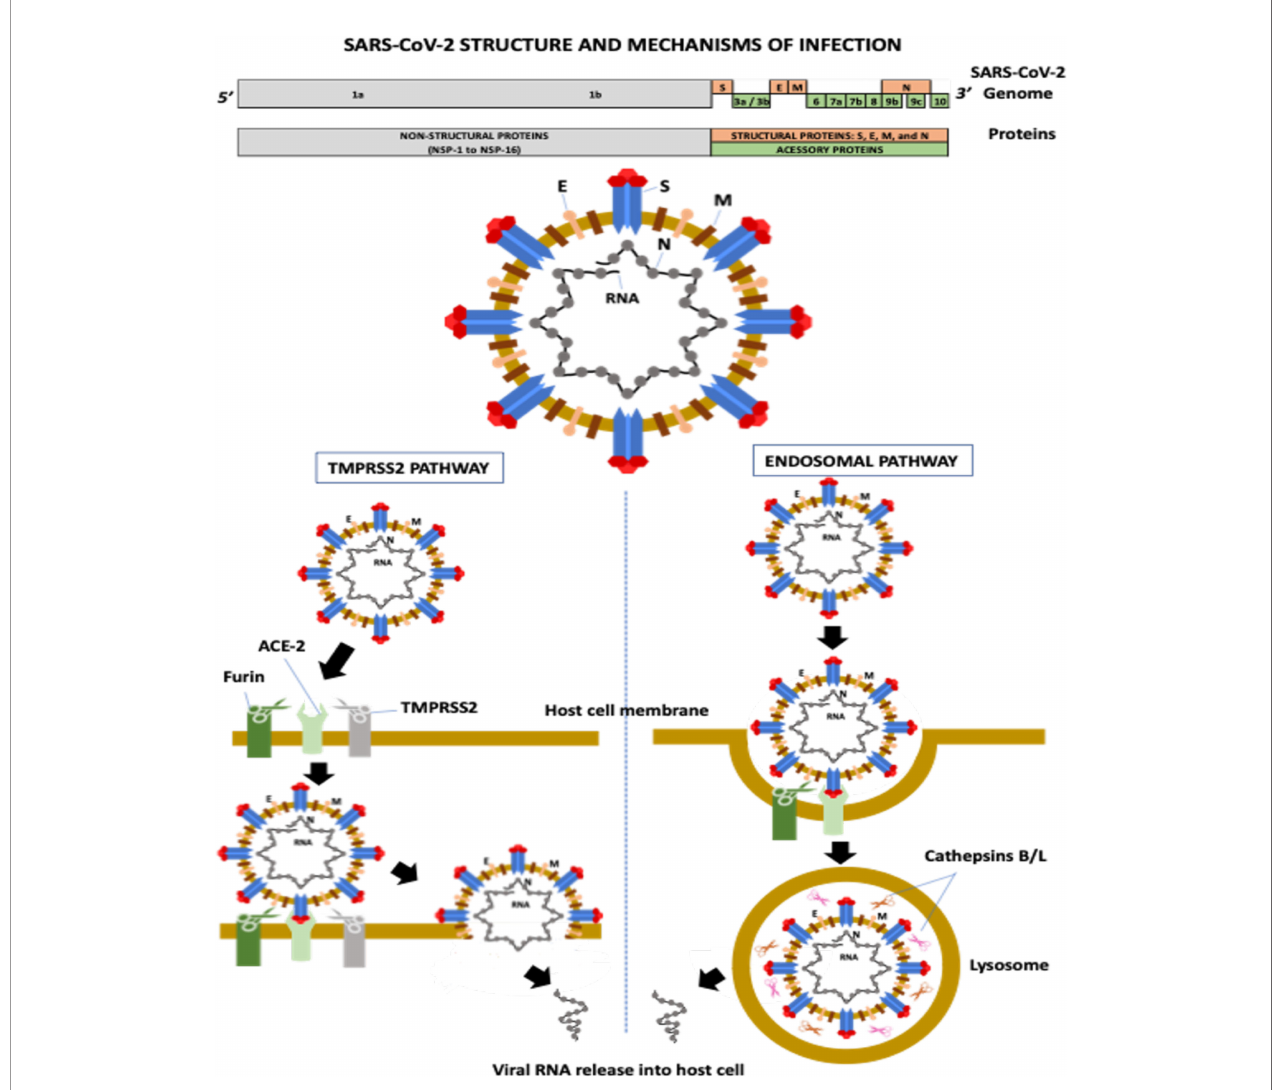
FIGURE 1 | SARS-CoV-2 structure and mechanisms of infection. ACE-2, angiotensin-converting enzyme-2; E, envelope; M, membrane; N, nucleocapsid; NSP, non-structural protein; S, spike; TMPRSS-2, transmembrane serine